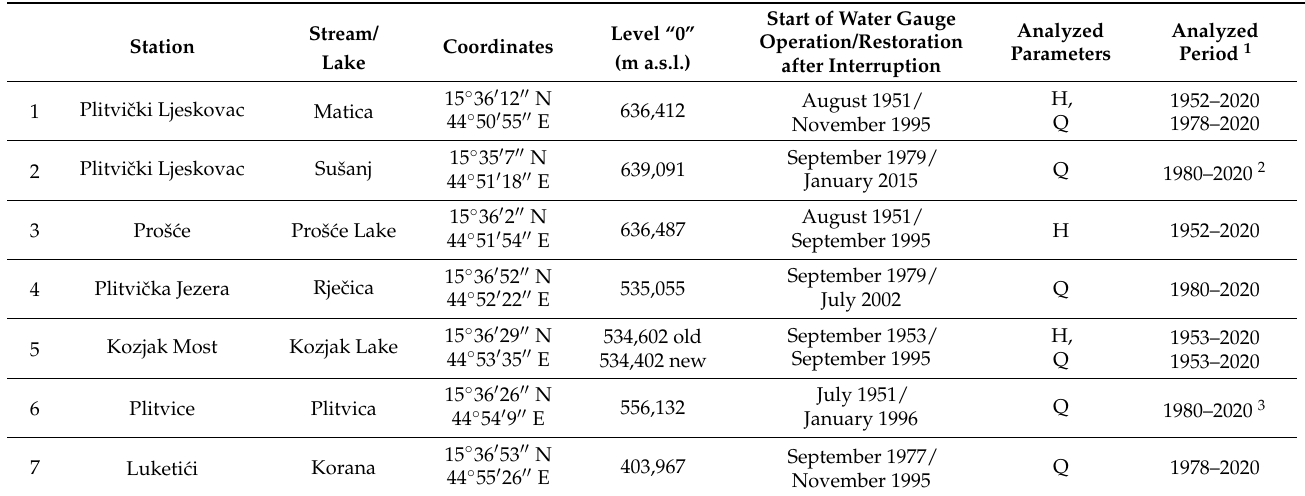
Table 1. Basic information about the analyzed hydrological stations.